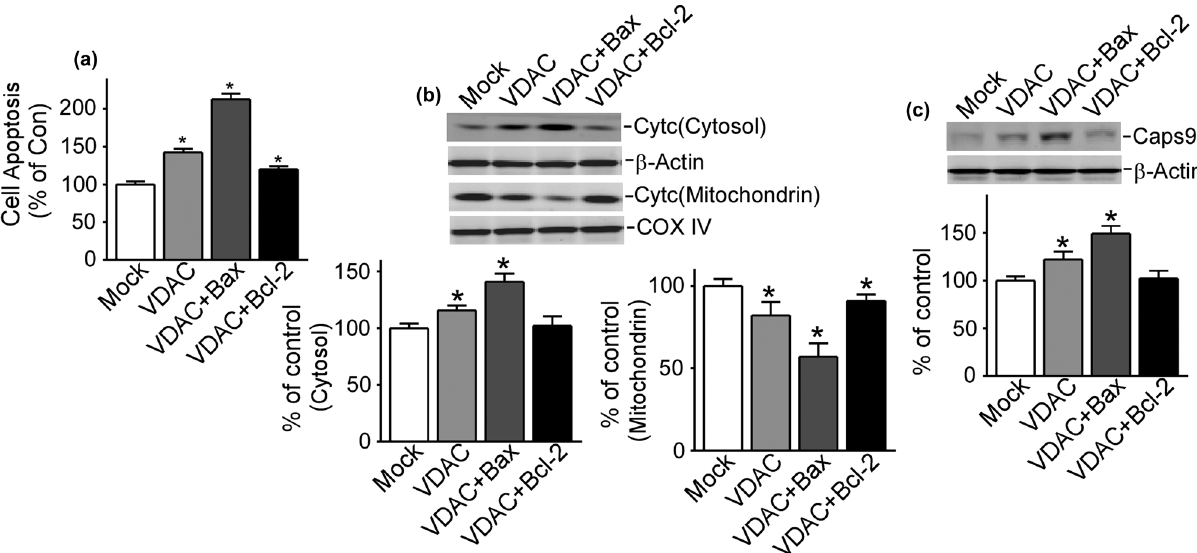
Figure 4: VDAC1 related to Bax and Bcl - 2 in refractory epilepsy. ( a – c ) Cell apoptosis, the release of Cyt C , and the expression of Caps9 with upregulation of VDAC1 and Bax, or VDAC1 and Bcl - 2. Cyt C means cytochrome C , Caps9 means caspase 9. Values represent means ± SD, n = 3. P < 0.05 by Student ’ s t -